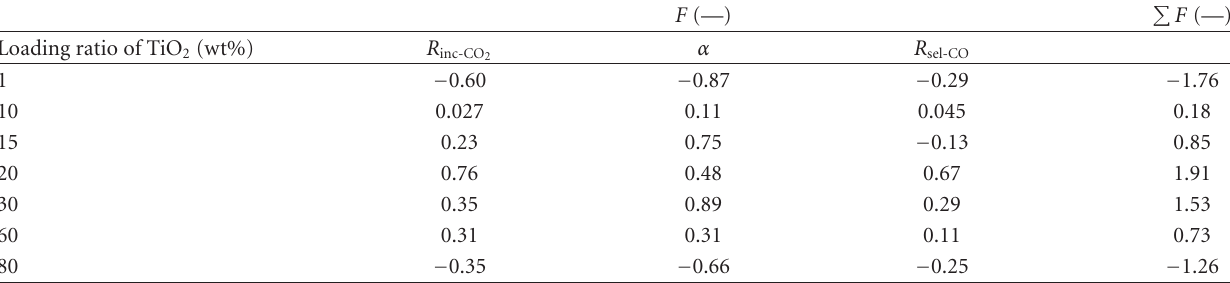
Table 2: Comparison of F and the summation of F for each loading ratio of TiO 2 .